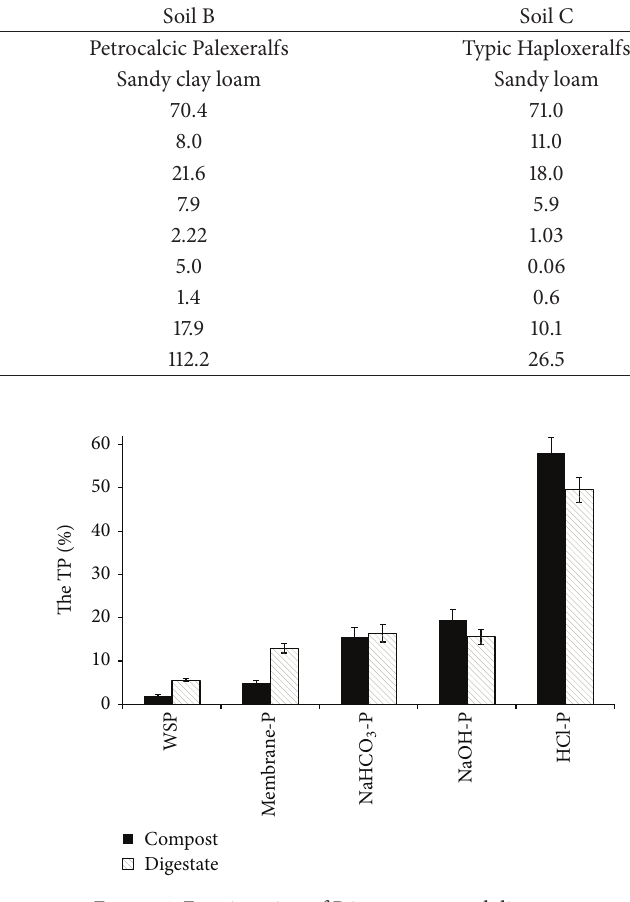
−3 −1 h ) than for soils with compost (1.7 10